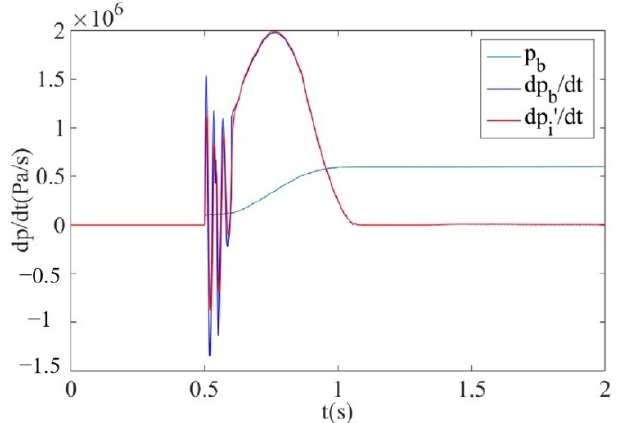
Figure 14. Simulation results of brake pressure change rate considering temperature change.